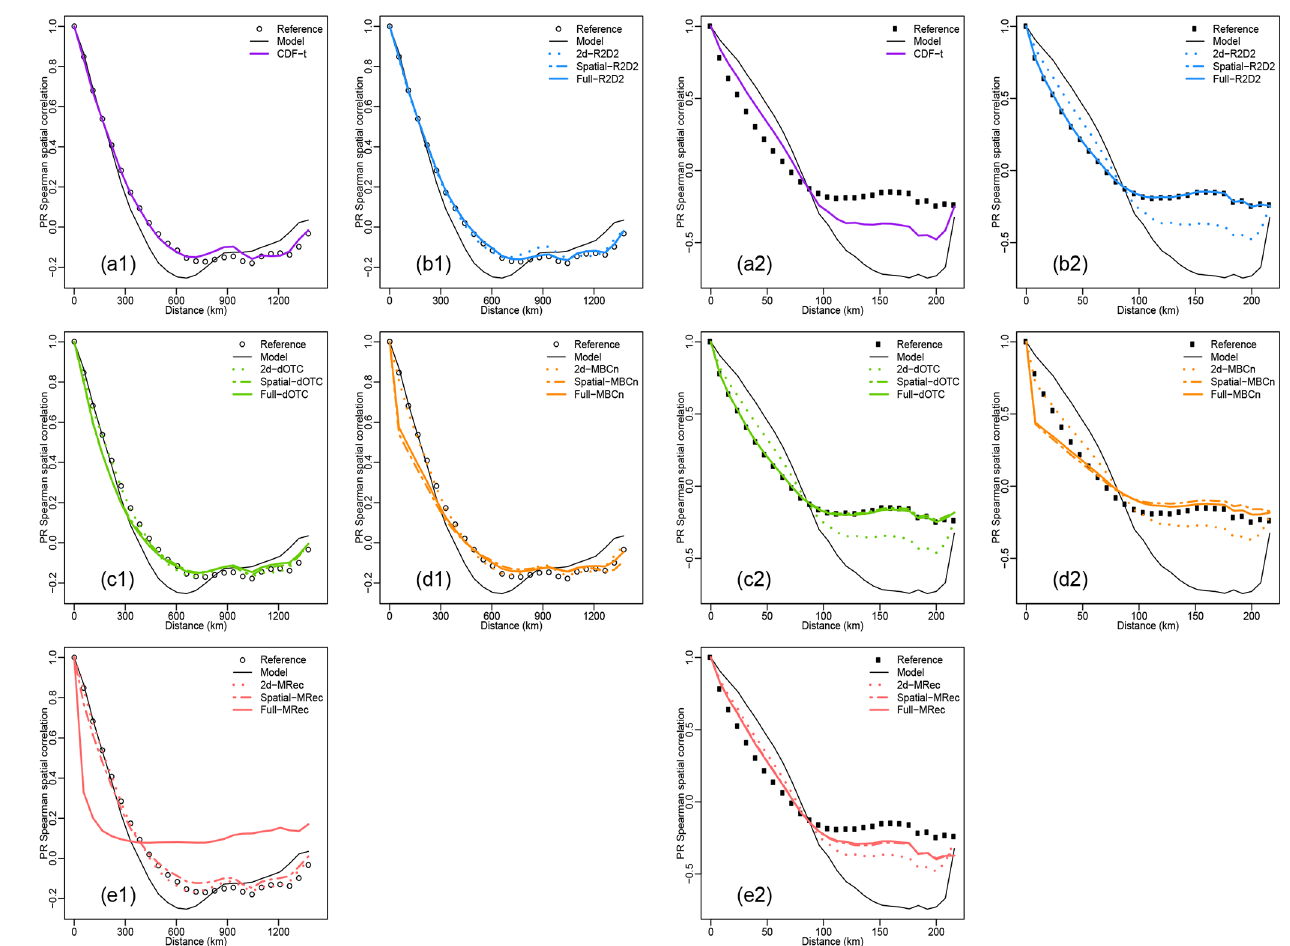
Figure 3. Correlograms for precipitation using (a1–e1) WFDEI reference for France and (a2–e2) SAFRAN reference for Brittany during winter over the 1979–2016 period. Results are shown for reference (circles) and plain IPSL (black line). Results are displayed for CDF-t, R 2 D 2 , dOTC, MBC-n and MRec outputs for 2d- (dotted), Spatial- (dashed) and Full- versions (solid